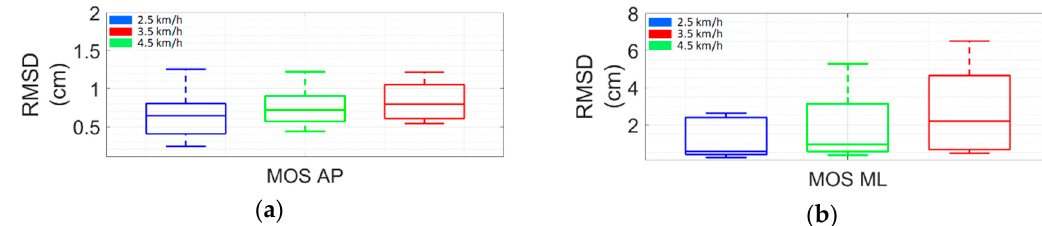
Figure 7. RMSD between MOS computed using MIMU- and camera-based data for each walking velocity along the ( a ) AP and ( b ) ML directions. Take note that the scale of the vertical axis scale is different between panels.